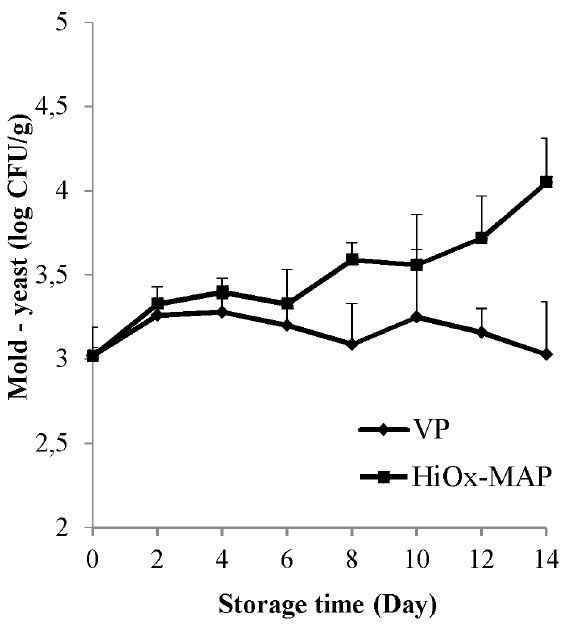
Figure 6. Effects of vacuum packaging (VP) and high-oxygen modified atmosphere packaging (HiOx-MAP, 80% O minced water buffalo meat at 2°C±0.5°C for 14 days. CFU, colony-forming